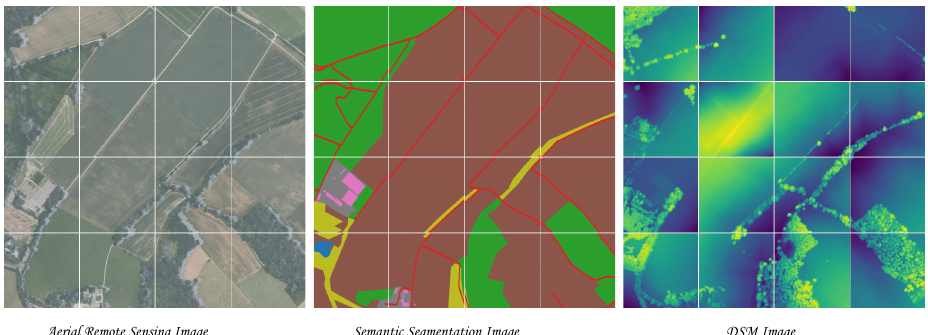
Figure 11. GeoNRW dataset Data Process. Data Fusion Contest 2018 (DFC2018) dataset [73]. The dataset is a collection of multisource optical images from Houston, Texas. The data include ultra-high resolution (VHR) color images resampled at 5 cm/pixel, hyperspectral images, and DSM and DEM obtained with lidar, particularly at 50 cm/pixel resolution. The original DCF2018 dataset does not contain a height map, so we use DSM minus DEM to obtain the height within the area. Figure 12 shows the distribution of the dataset.